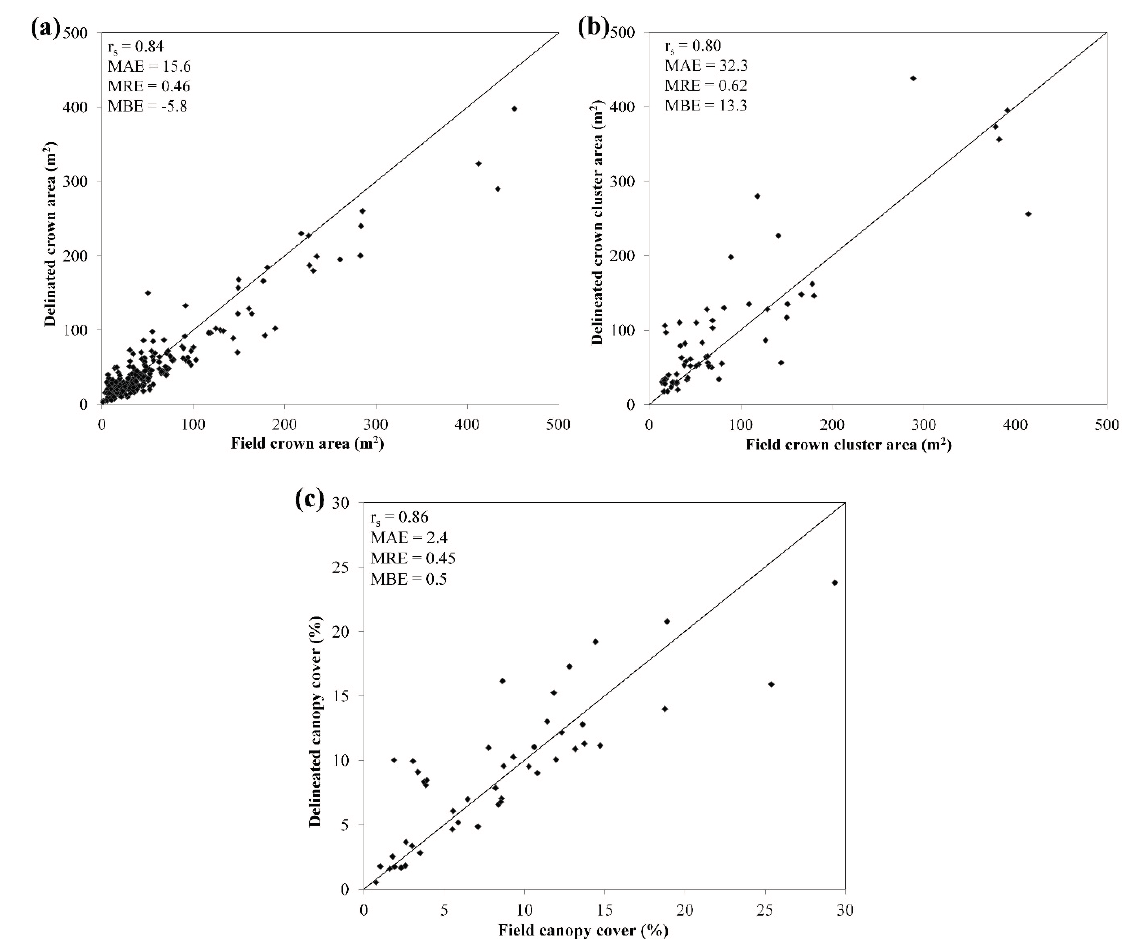
Figure 6. Graphs of the correlation between field data and remote sensing data (delineated) showing ( a ) crown area of ITC; ( b ) crown cluster area; and ( c ) tree canopy